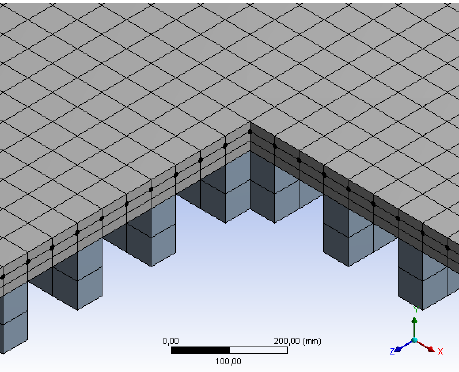
Figure 9. Detail of reinforcement